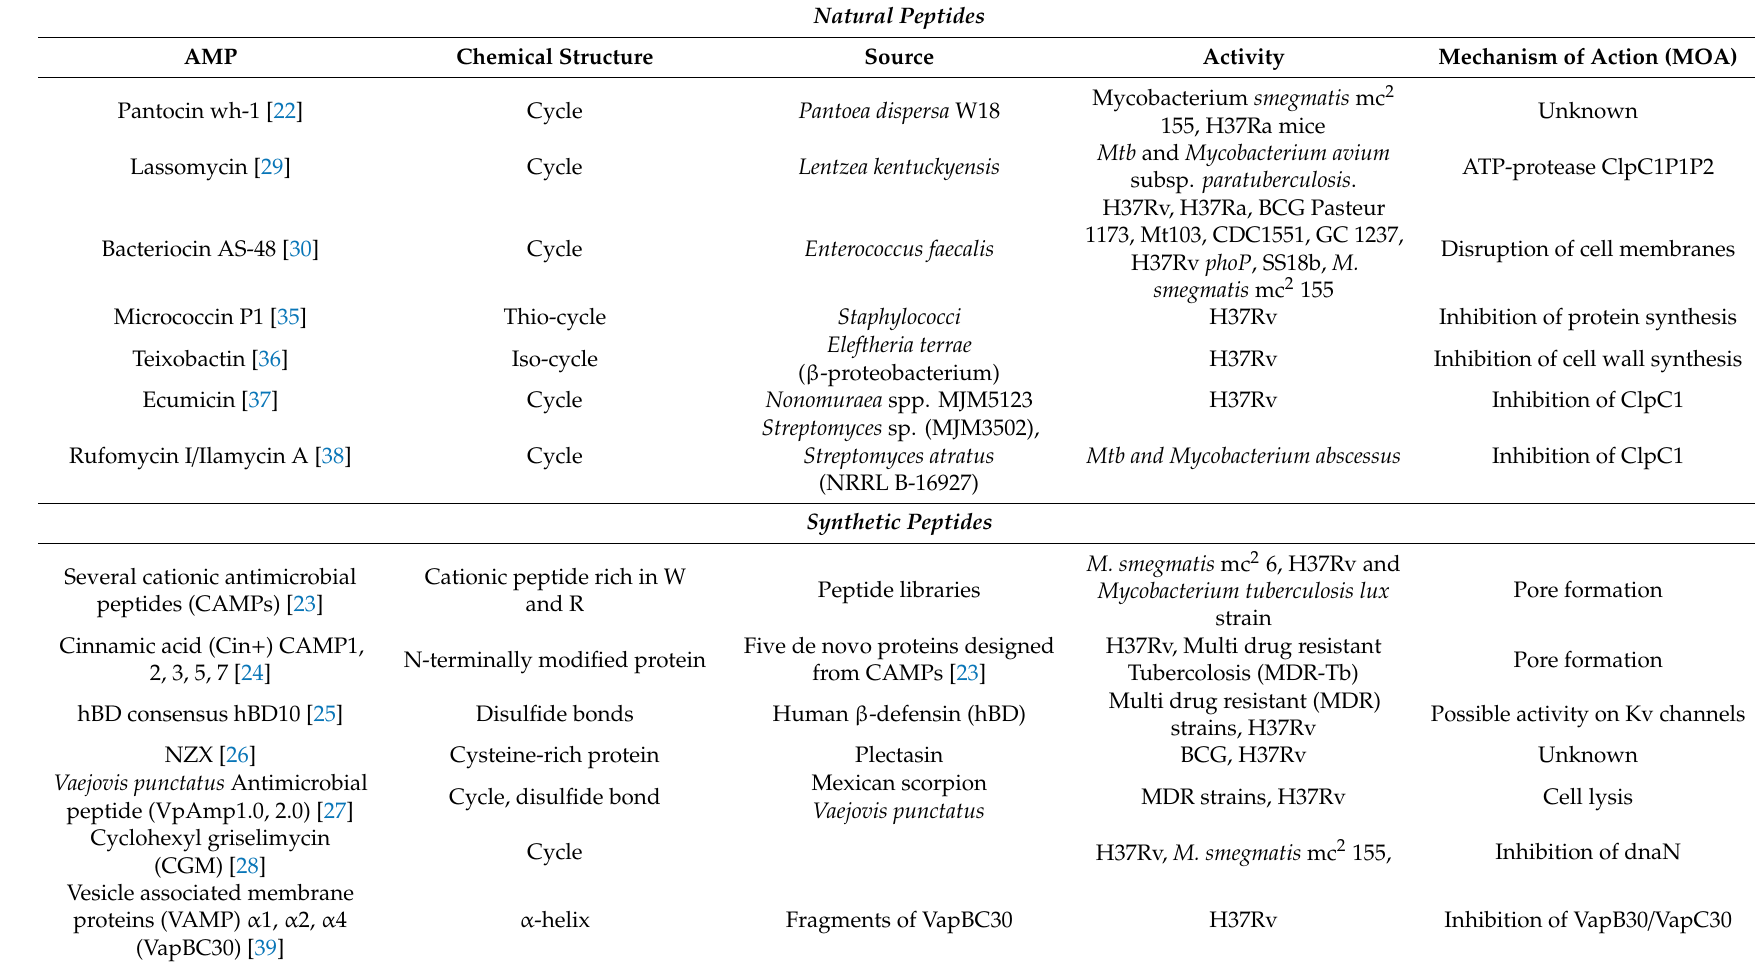
Table 1. Examples of recently developed ( 2013–2020 ) natural and chemically modified Antimicrobial peptides (AMPs) against